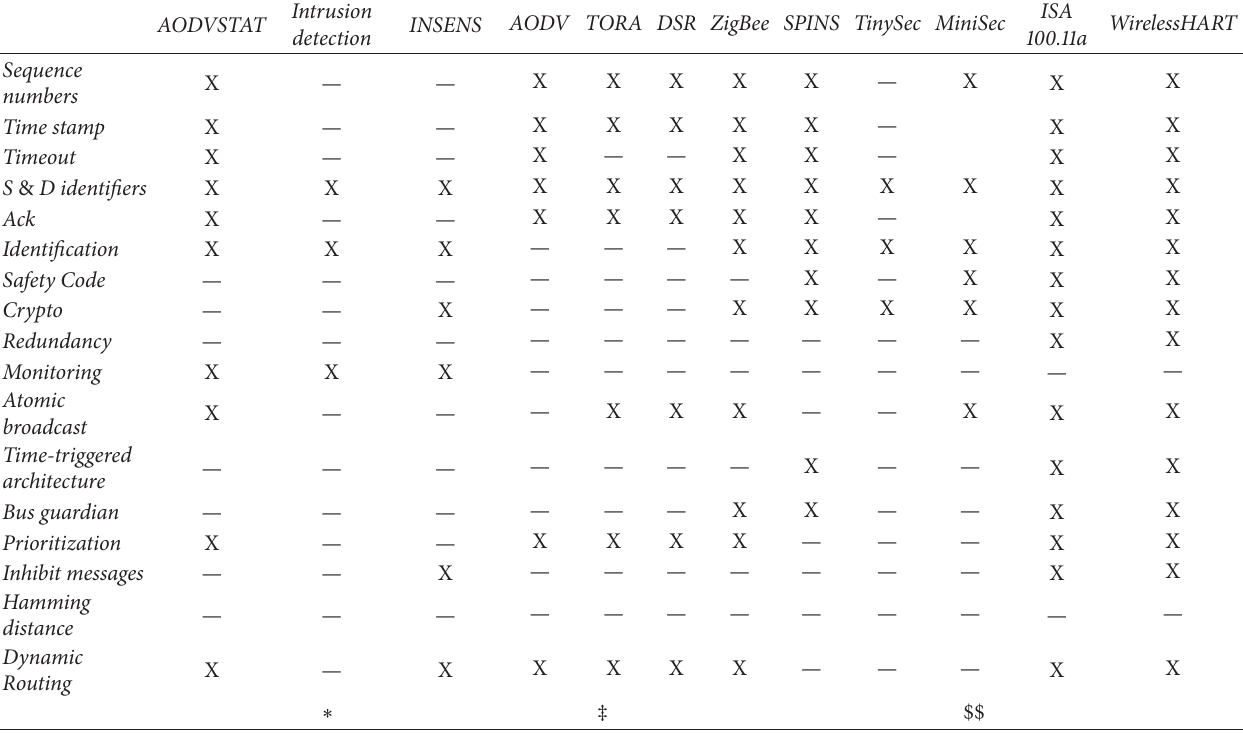
Table 6: WSN protocols comparison